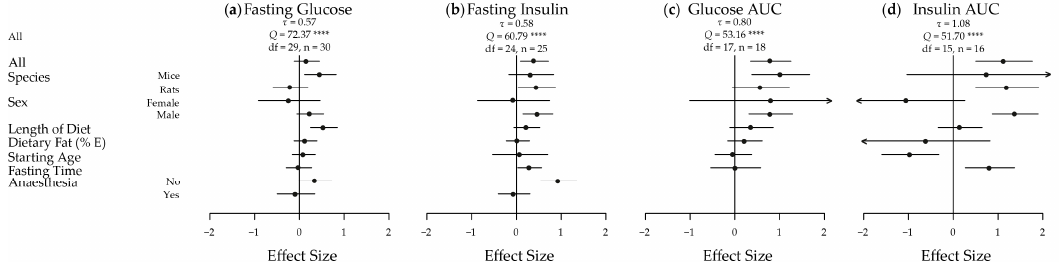
Figure 3. Meta-analysis of the extracted results for measures of glucose homeostasis in high versus low glycaemic index fed animals. A plot of the calculated effect size and sampling variance for each of the four traits either as a whole or broken down by confounding factor: ( a ) Fasting Glucose; All, Length of Diet, Dietary Fat and Fasting Time n = 30, Mice n = 16, Rats n = 14, Female n = 4, Male n = 26, Starting Age n = 27, No Anaesthesia n = 17, Anaesthesia n = 13; ( b ) Fasting Insulin; All, Length of Diet, Dietary Fat and Fasting Time n = 25, Mice n = 9, Rats n = 16, Female n = 3, Male n = 22, Starting Age, n = 23, No Anaesthesia n = 12, Anaesthesia n = 13; ( c ) Glucose AUC; All, Length of Diet, Dietary Fat and